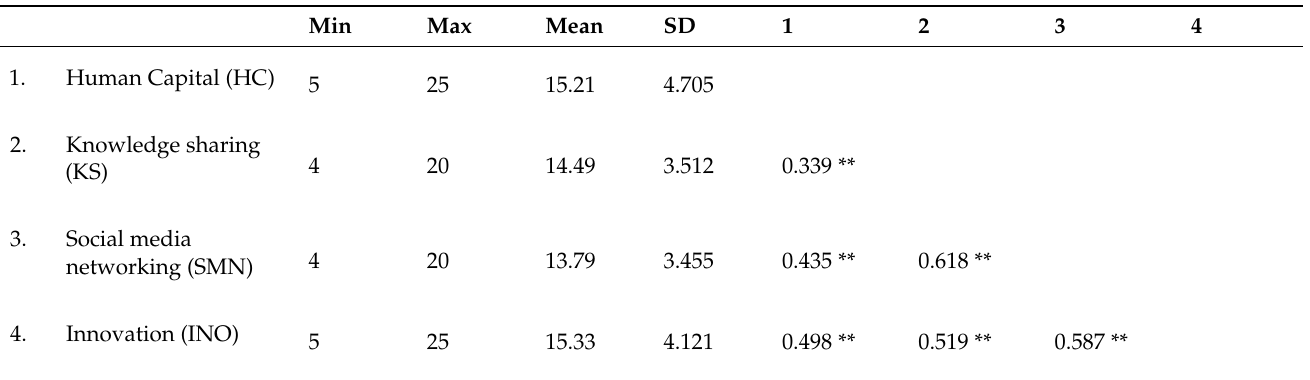
Table 3. Descriptive statistics and correlation